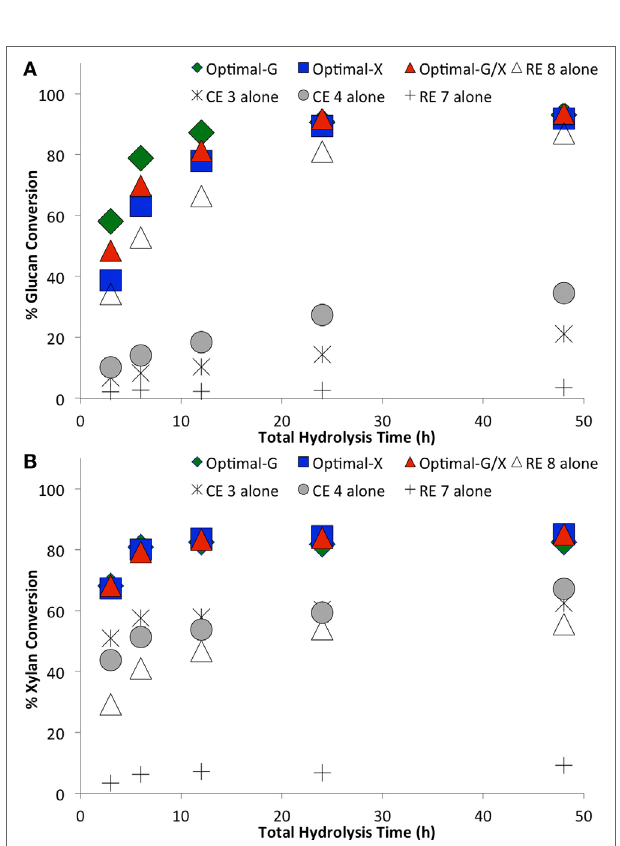
FigUre 5 | comparing optimal versus non-optimal commercial enzyme (ce) combinations on glucan-to-glucose (a) and xylan-to- xylose (B) percent conversions for ammonia fiber expansion-treated corn stover as a function of hydrolysis time . Total protein loading was 15 mg/g glucan. Optimal G, optimal X, and optimal G/X represent enzyme combinations that gave the highest glucose, xylose, and total sugar (glucose + xylose) yields, respectively. Mean values are reported here, while SDs in all cases was less than 2% and is not shown here for sake of